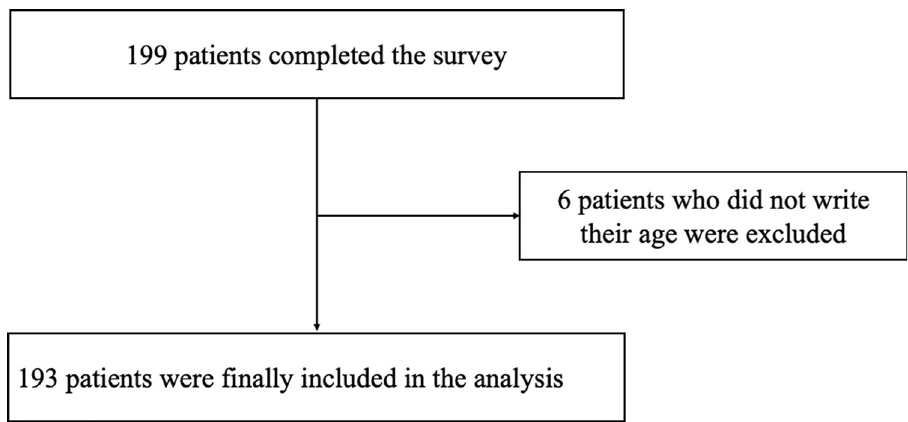
Fig 2. Study design and participant